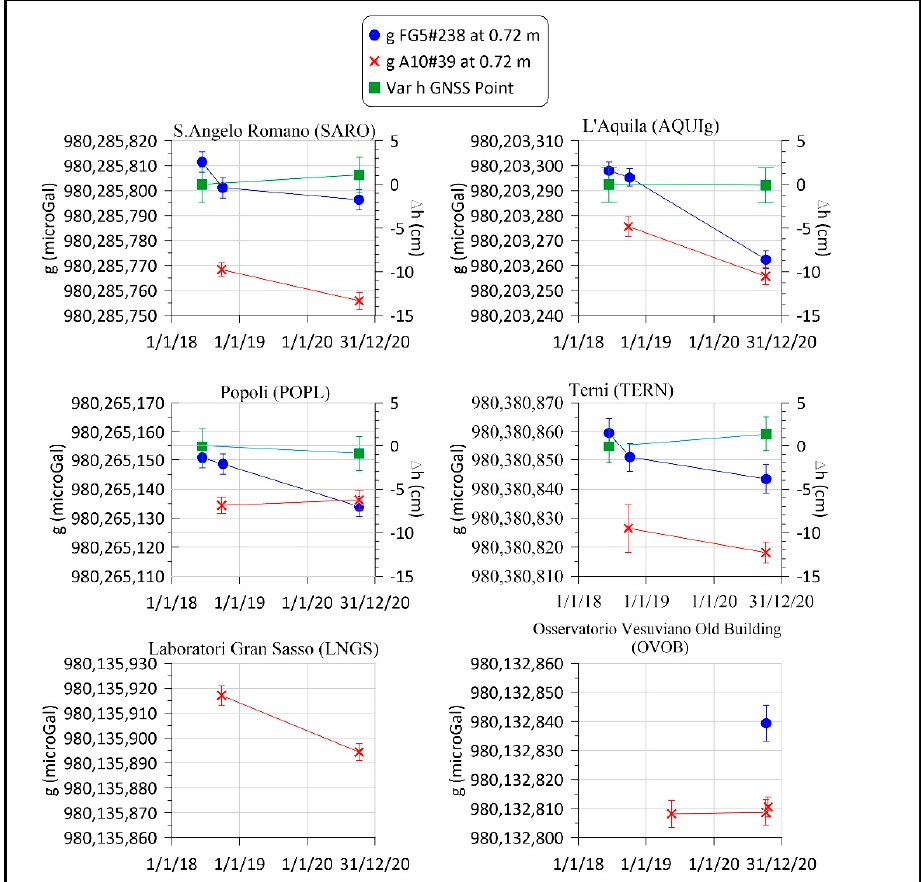
Figure 5. Gravity changes at the five stations of the network detected through absolute gravity measurements using the FG5#238 and A10#39 gravimeters. The bottom right figure shows the absolute values measured at the historic Osservatorio Vesuviano Old Building (OVOB) in 2019 and 2020 with the A10#39 and in 2020 with the FG5#238; the latter measurements allowed for comparison of the two instruments (see the text for further details).